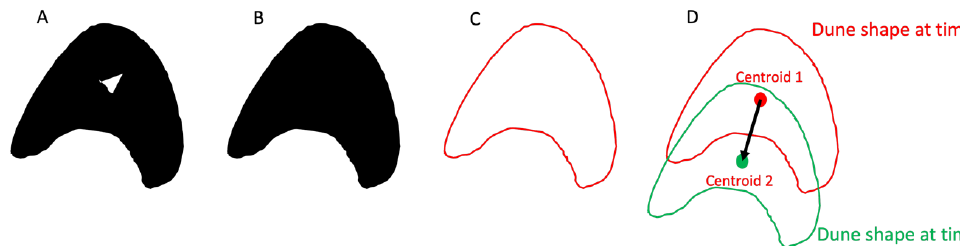
Figure 7. Schematics of: ( A ) Detected dune, ( B ) Filled dune, ( C ) Polygonized dune and ( D ) dune movement computation based on centroid difference, resulting in the black arrow symbolizing the displacement vector.